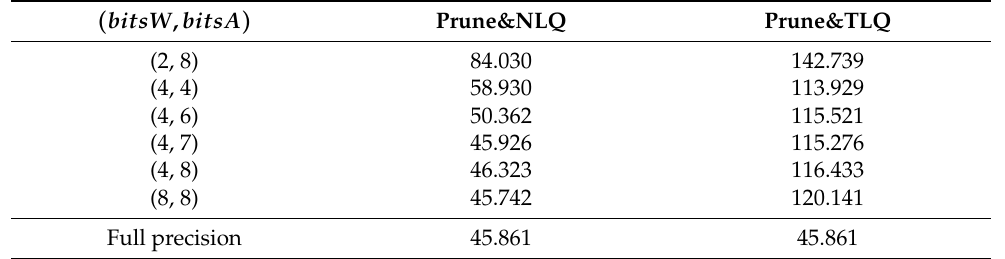
Table 3. The perplexity of a model using two compression approaches with different bit-width. ( bitsW , bitsA